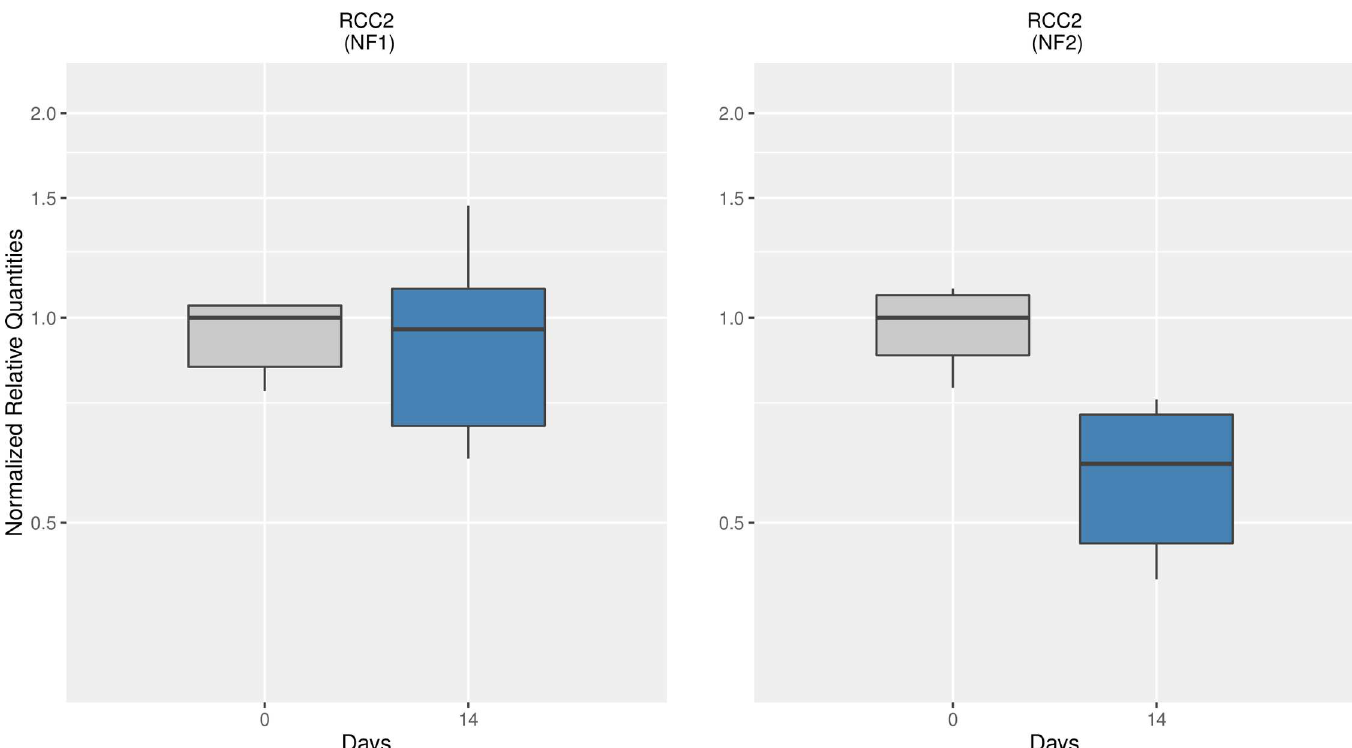
Fig 4. Normalized relative quantities of RCC2 over days 0 and 14. Data were normalized for each sample against the 2 best-scored(NF 1 ) and the 2 worst- scored references (NF 2 ). NRQ were rescaled to day 0 that was arbitrarily set as